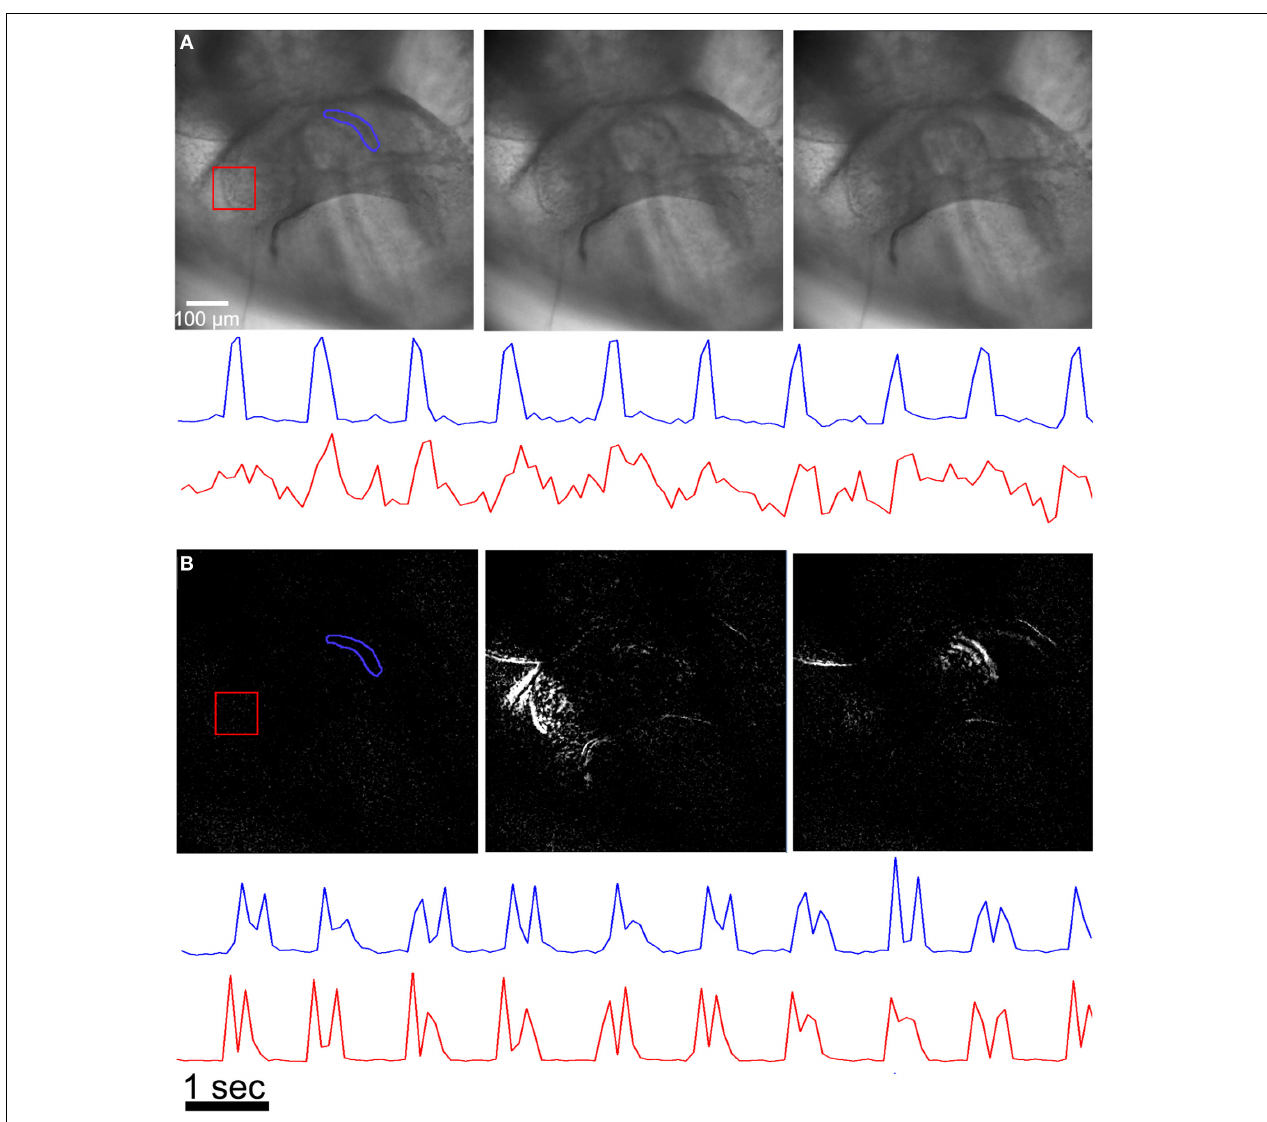
FIGURE 4 | Assessing contractility from image sequences. (A) A ROI (region of interest) where the ROI is carefully chosen to surround a high contrast feature in the image (blue polygon and trace) can be used to assess periodicity when the intensity from all pixels within the region are plotted as a function of time. A ROI that contains both high and low contrast features yields an intensity vs. time plot that is difficult to interpret (red polygon and